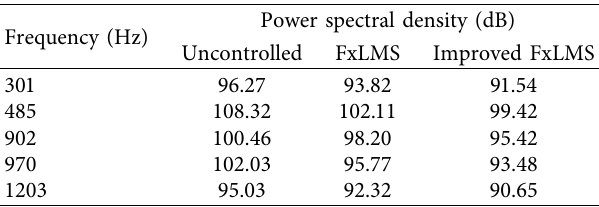
Table 4: Active vibration control of the gear system at 1530r/min and 1N